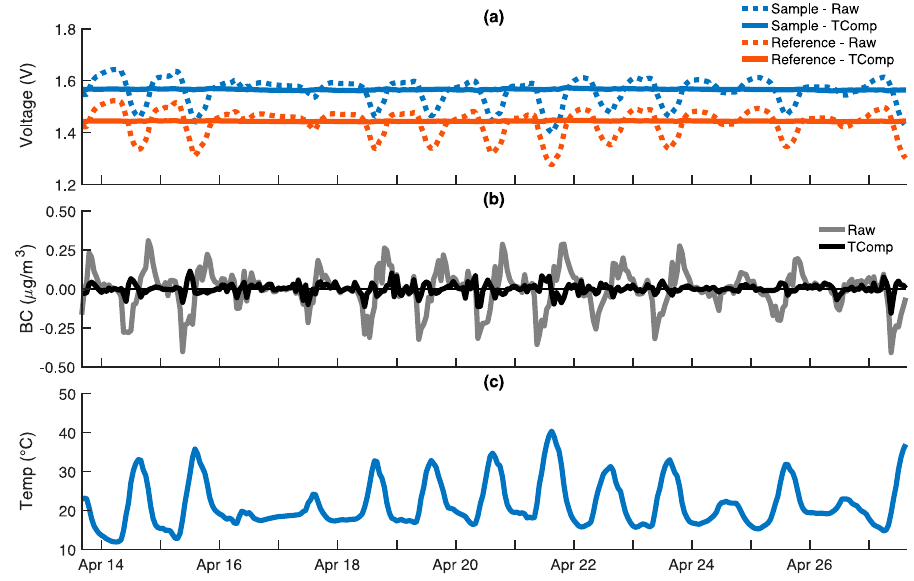
Figure 6. The response of an ABCD operating outdoors with a HEPA filter on its air inlet for two weeks. Temperature-compensated responses (solid) are shown in addition to the uncompensated responses (dashed) previously provided in Figure 4: ( a ) Sample (blue) and reference (red) voltage outputs from optical cell; ( b ) Uncompensated (gray) and temperature-compensated (black) black carbon (BC) concentrations; ( c ) Optical cell temperature. All data is provided on a 60-min time base.